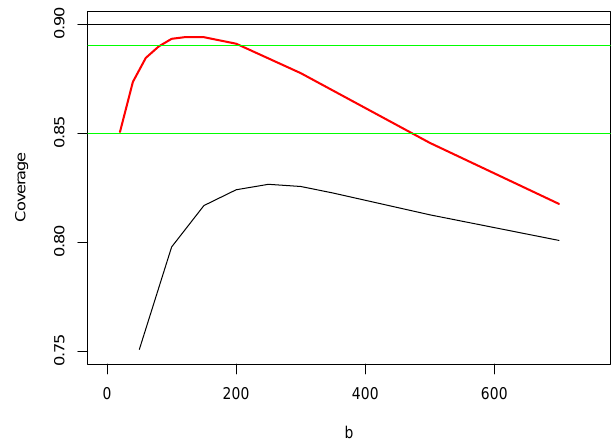
Fig. 2. Actual coverage probabilities of 90% subsampling CIs with β = 0 . 50 (black) and β = 0 . 42 (red) for the skewness of nonlinear time series ( 4) at a = 0 . 145 and n = 2048. Horizontal green lines denote 0.85 and 0.89 levels. Table 1. Parameters of the model time series X t (Eq. (4)) distribu- tion vs sample characteristics of the observed series W t in Fig.1.